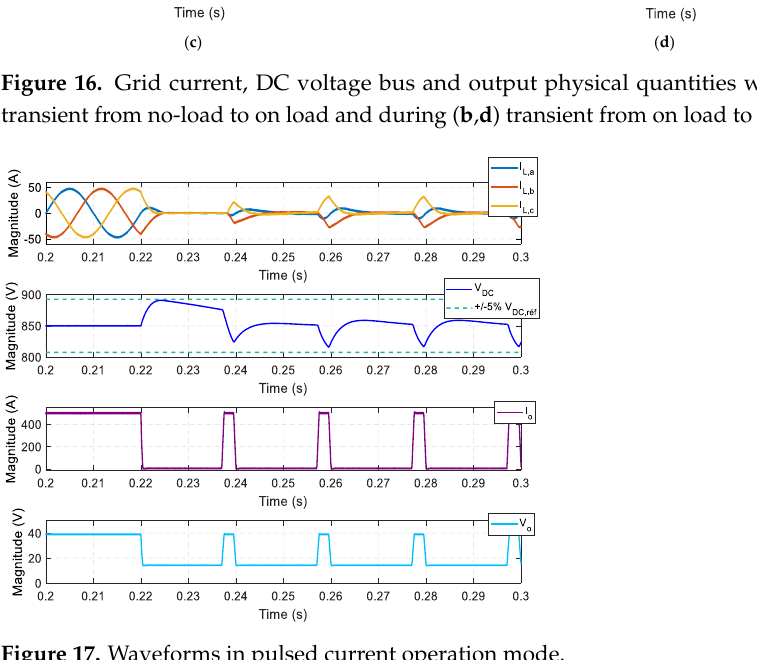
In the absence of electric arc, thus with a null output current, the return of the volt- age bus to its reference value is slower after a voltage peak since the circuit dynamics for